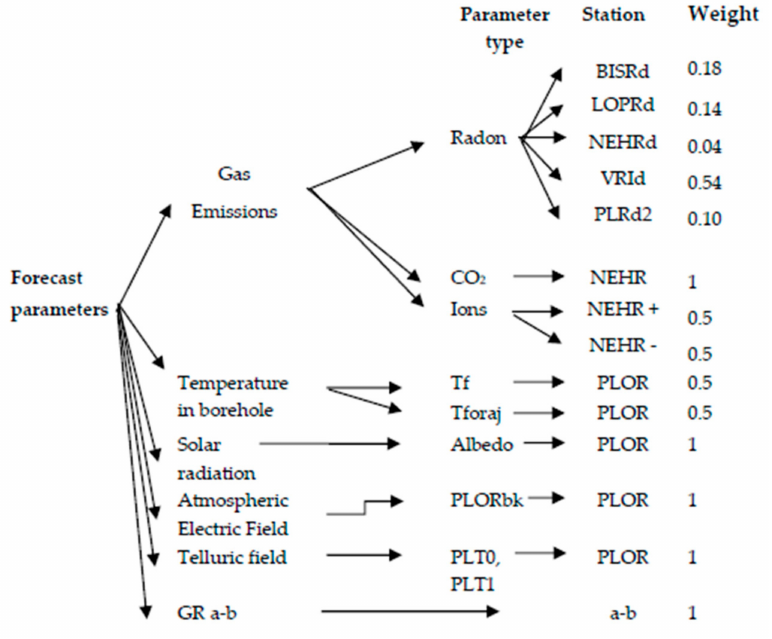
Figure 16. Logic tree of forecast parameters of Vrancea